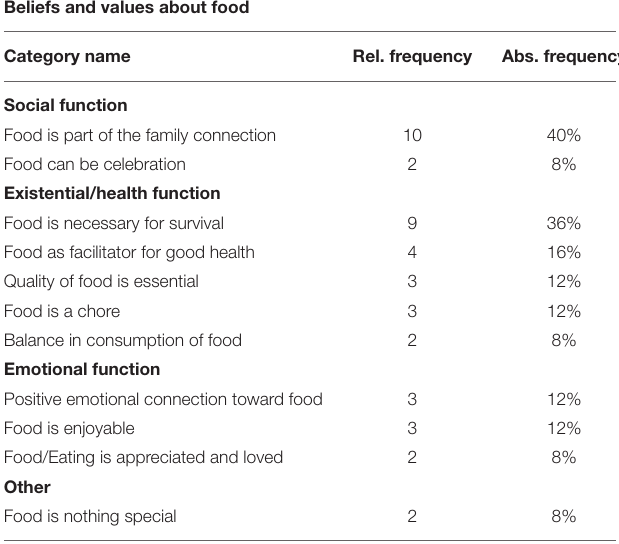
TABLE 1 | Beliefs and values about food found in 25 guideline-based interviews (inductive category system; categories with single occurrence are not mentioned in the category